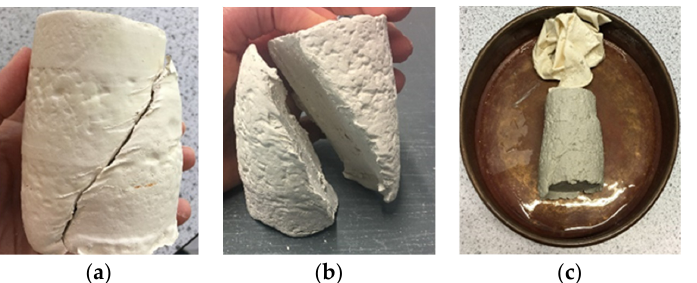
Figure 10. Sheared triaxial samples of: ( a ) the pure clay; ( b ) 15% fly ash-stabilized clay; ( c ) 25% fly